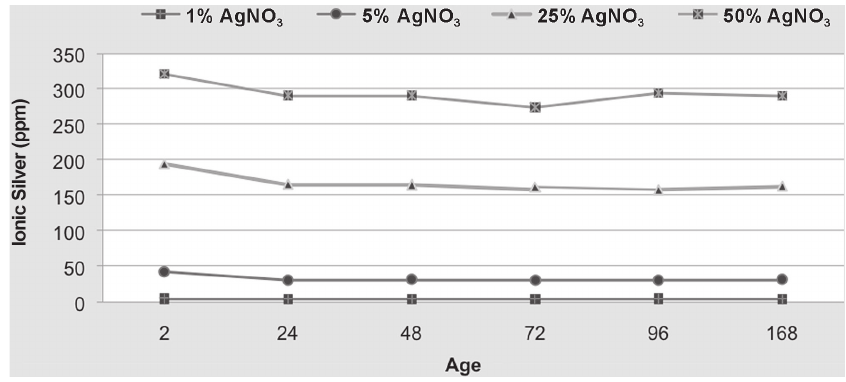
Figure 3- Distribution of the amount of ionic silver in the solutions according to the post-preparation times and concentrations